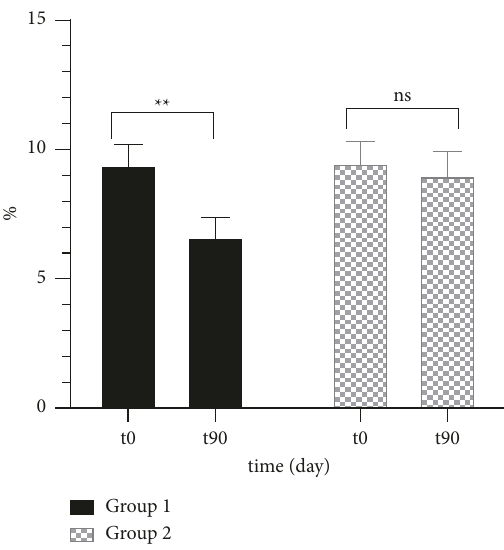
Figure 3: HbA1c variations during camel milk treatment.